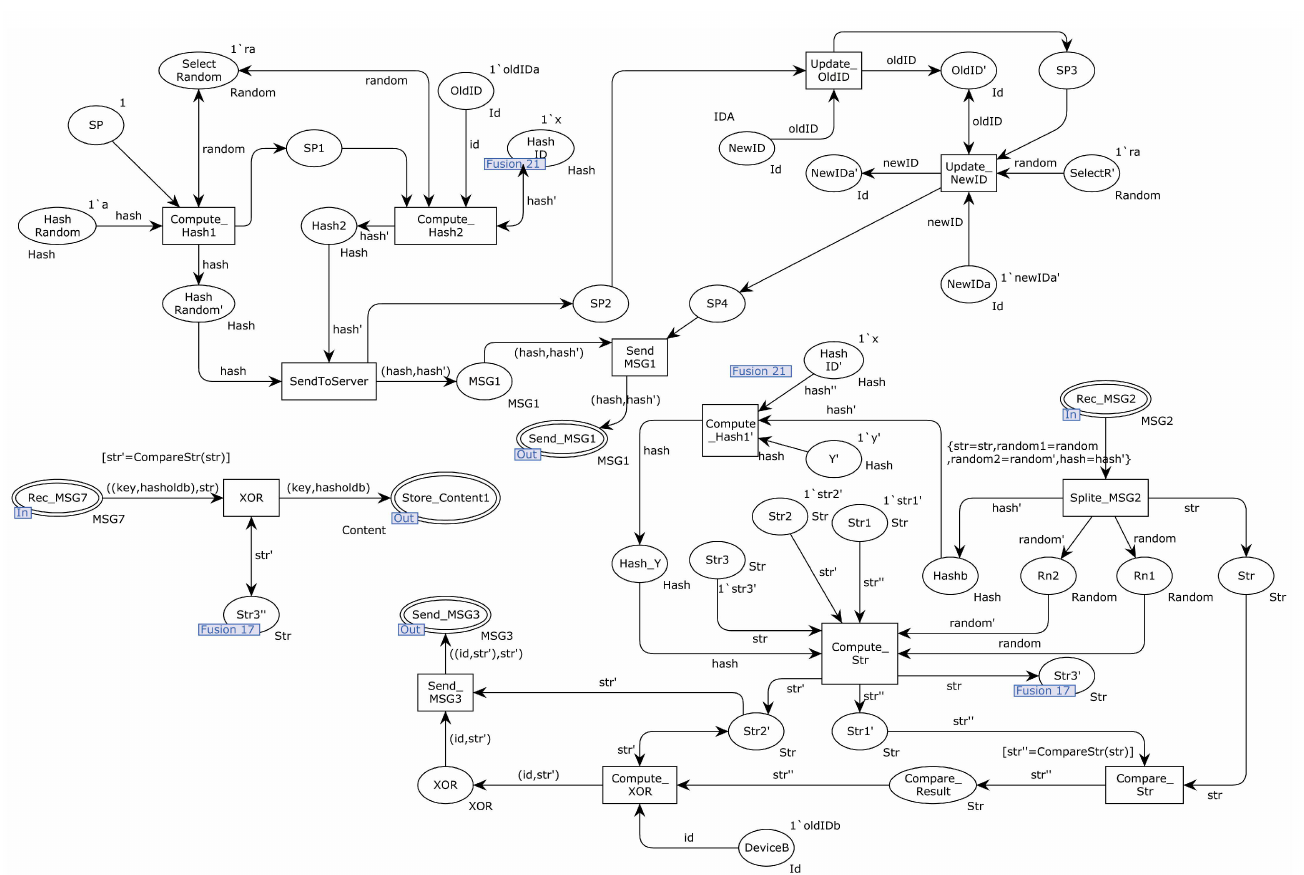
Figure 12. Substitution transition Authentication_Server internal